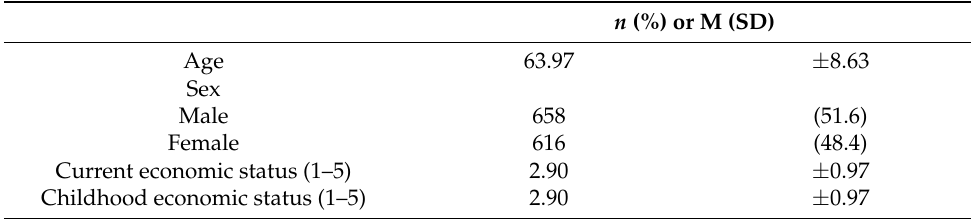
Table 1. Participant Characteristics.